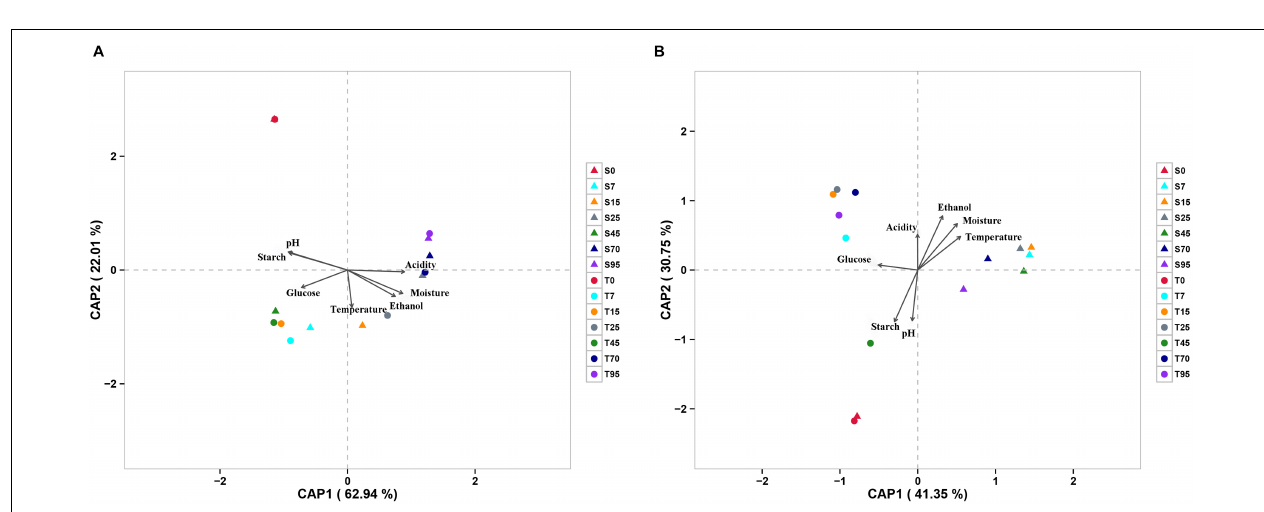
FIGURE 3 | The Bray–Curtis distance PCoA of bacterial (A) and fungal (B) communities during the SCSSF and TCSSF processes, as obtained by Illumina HiSeq sequencing analysis.